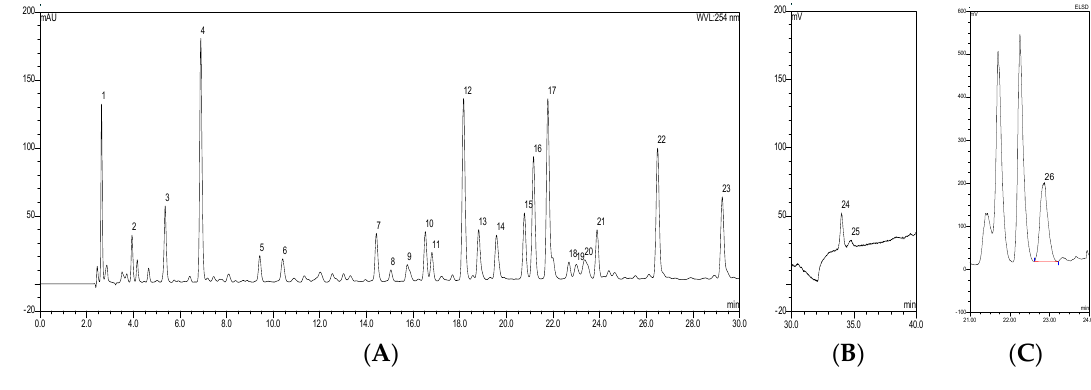
Figure 2. The HPLC fingerprint of GBE with UV ( A ) and ELSD ( B ); ( C ).